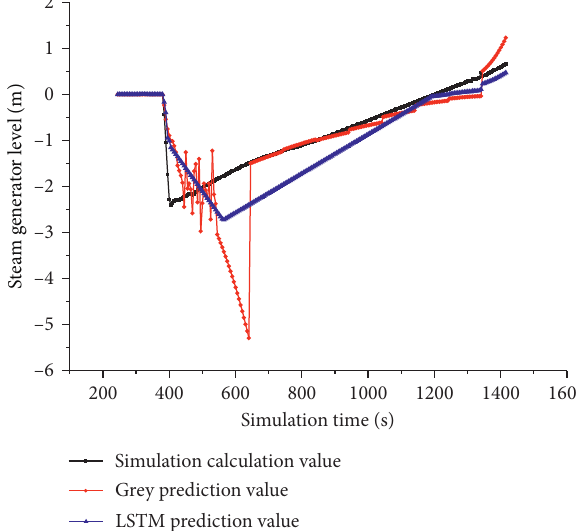
Figure 14: The comparison of the actual and predicted data of the steam generator water level.